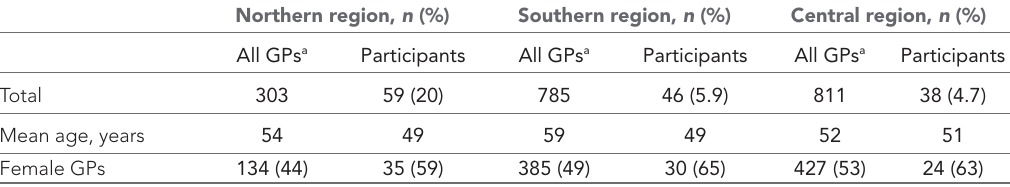
Table 1 Characteristics of the 143 participating GPs compared to all GPs in each